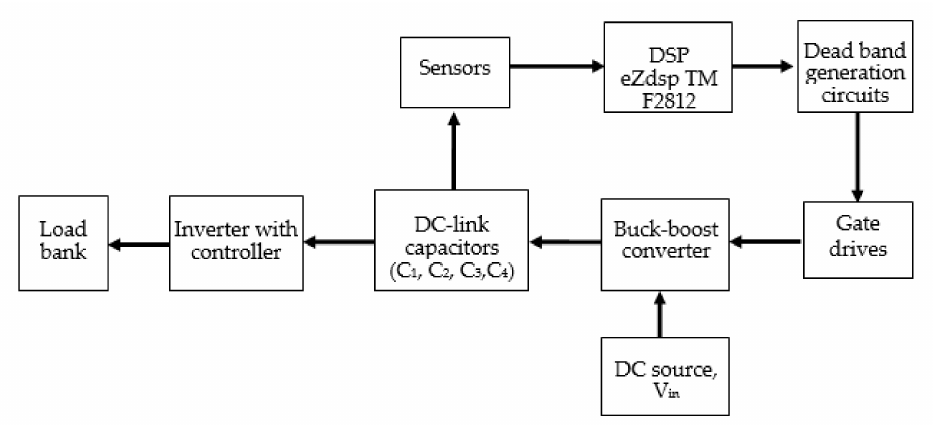
Figure 11. Block diagram of experimental setup for capacitor voltage balancing.